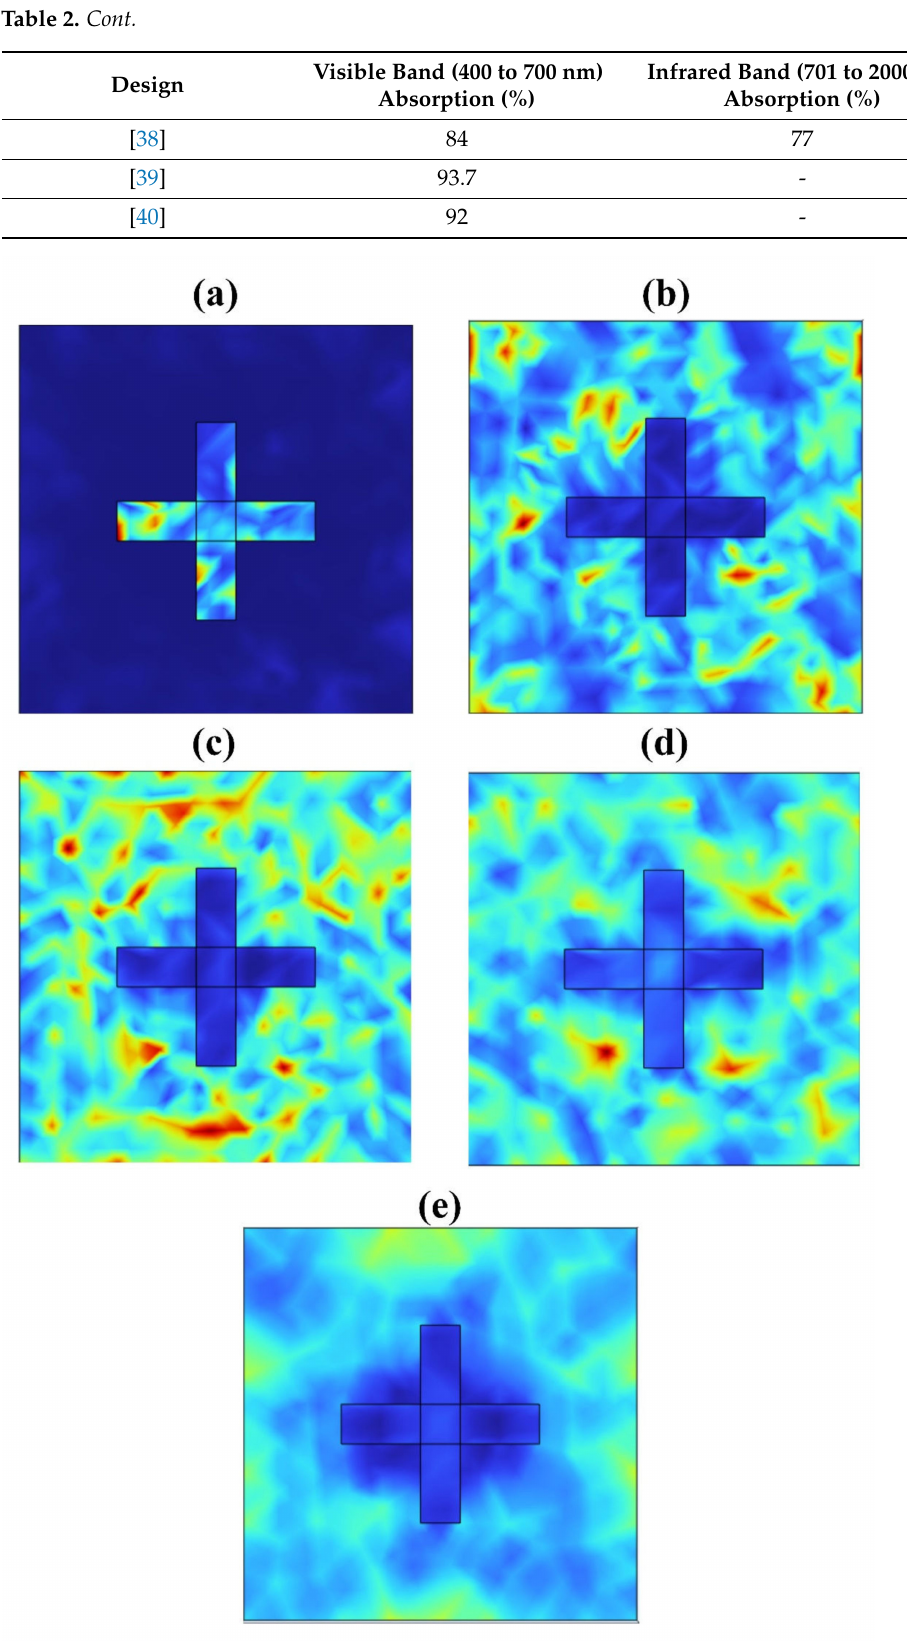
Figure 7. Electric field intensity (|E|) response for ( a ) 100 nm, ( b ) 400 nm, ( c ) 700 nm, ( d ) 1000 nm, and ( e ) 1500